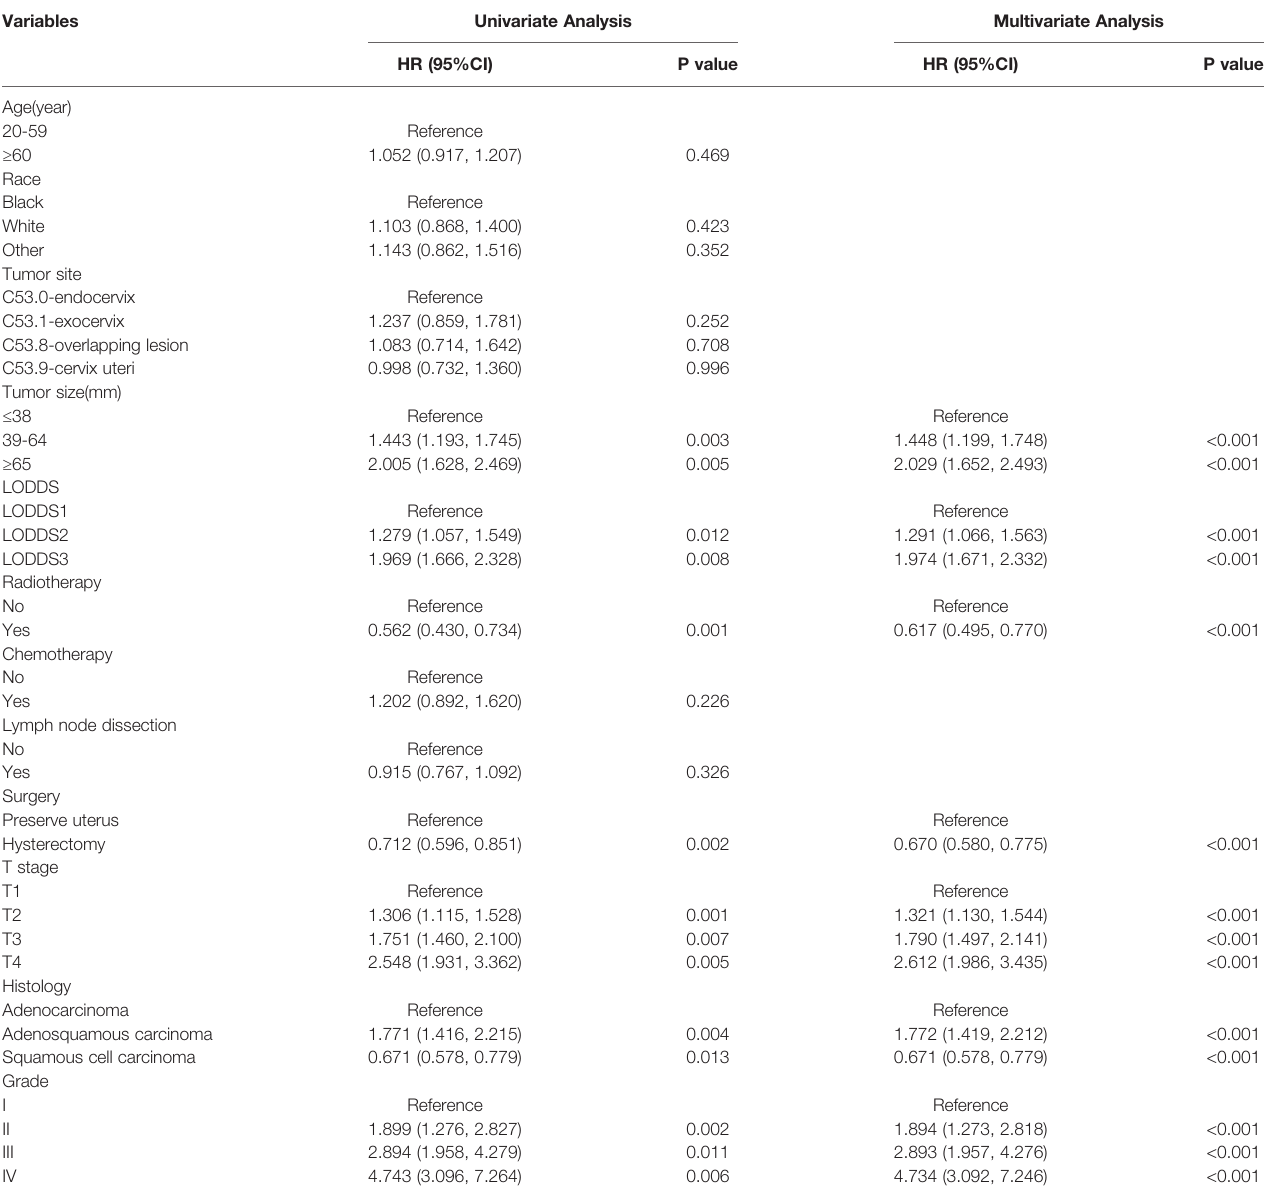
TABLE 3 | Univariate and multivariate Cox regression analysis of CSS in cervical cancer patients with lymph node metastasis (training